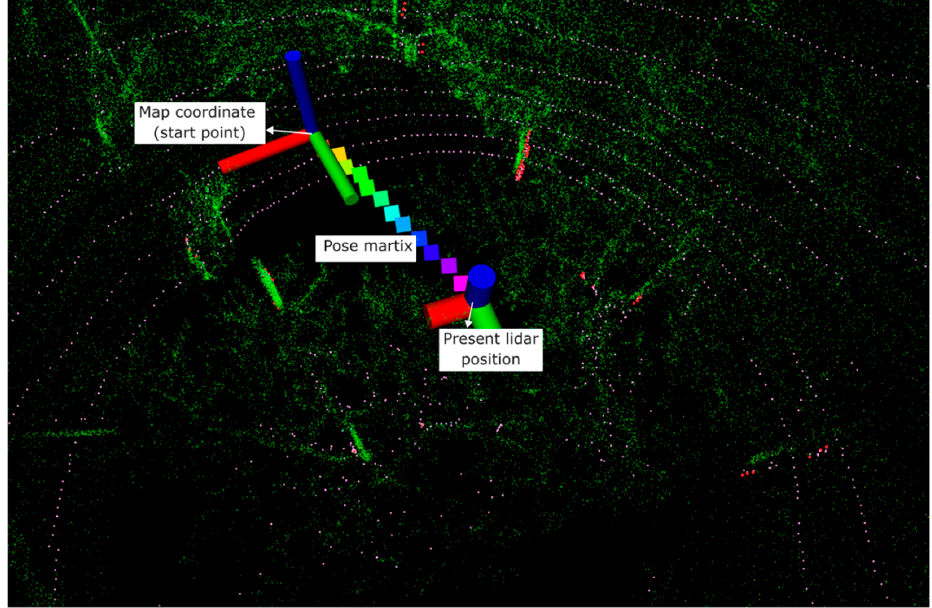
Figure 3. The point cloud was built from LeGO LOAM SLAM when walking in the field (green points are the matched points; pink points are the features of the surface point; red points are the point features of the edge).